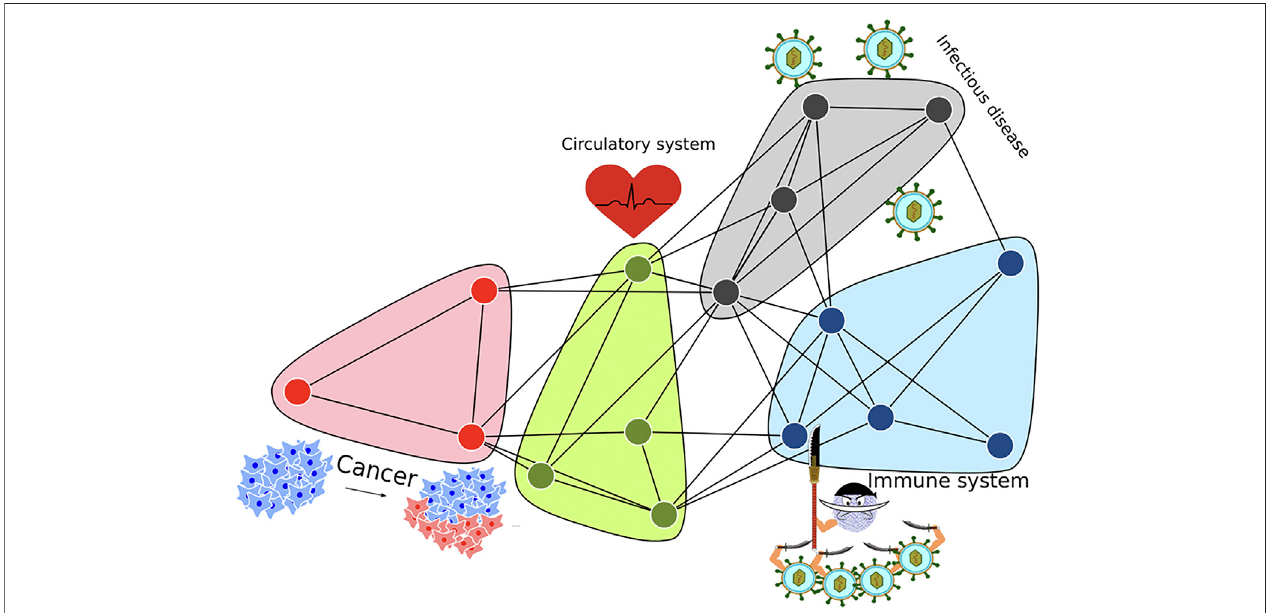
FIGURE 1 | Gene sets derived from experiments are often complex with multiple affected pathways. This illustration shows genes that belong to 4 pathways that are functionally distinct. The mixture of pathways may complicate the pathway enrichmentanalysis, especially for smaller pathways. By separating gene clustersprior to pathway analysis, a clearer picture of the pathway enrichment can be